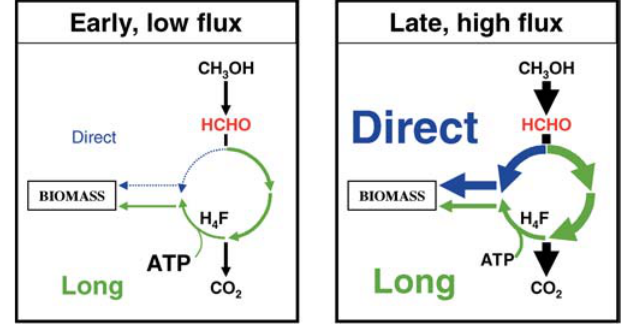
Figure 6. An Interconnected Metabolic Loop for Handling the Toxic Intermediate Formaldehyde A dynamic transition occurs from low to high formaldehyde flux, shifting the ratio of the direct versus long routes, and in the relative proportion of carbon oxidized to CO 2 versus assimilated, creating a buffer system to accommodate large changes in formaldehyde flux. DOI: